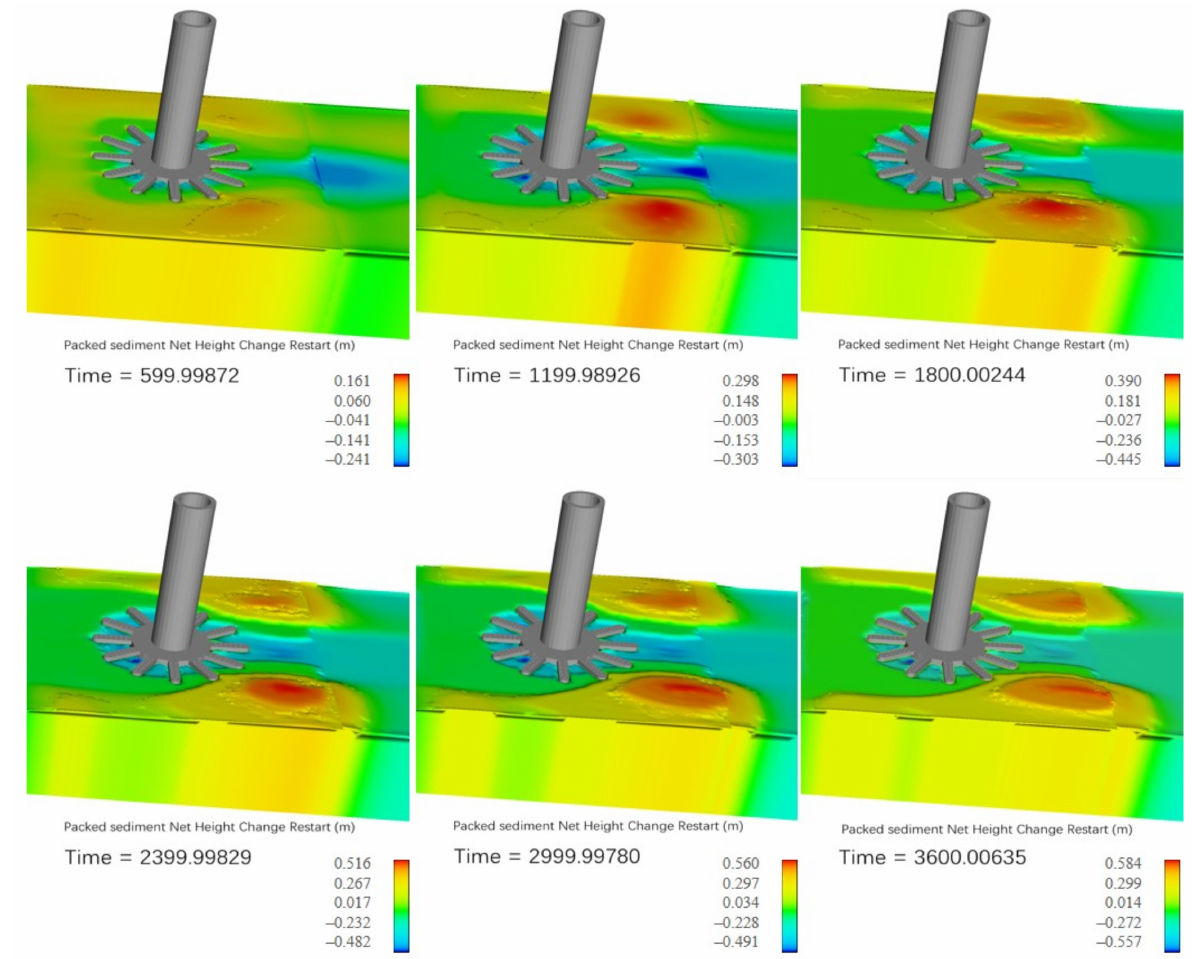
Figure 9. Scour morphology under different times for case